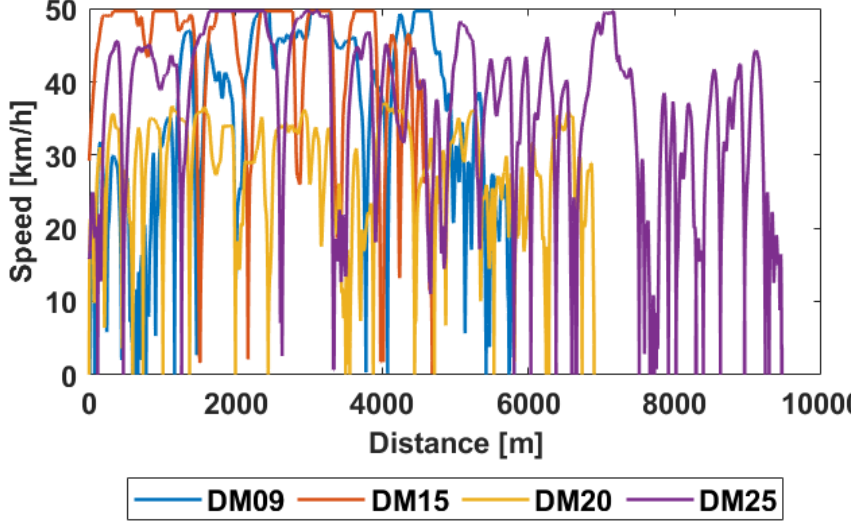
Figure 11. Velocity trajectories of the four experimental driving missions considered for the validation of the model.